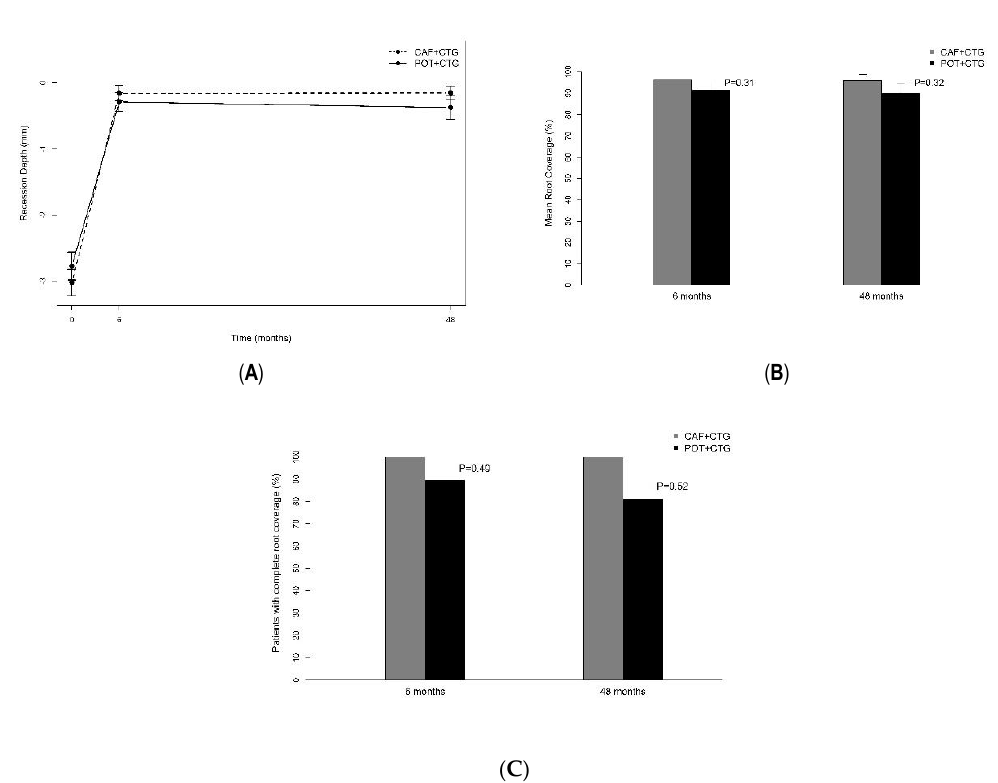
Figure 3. ( A ) Recession depth (mm), ( B ) mean root coverage (%) and ( C ) complete root coverage (%).